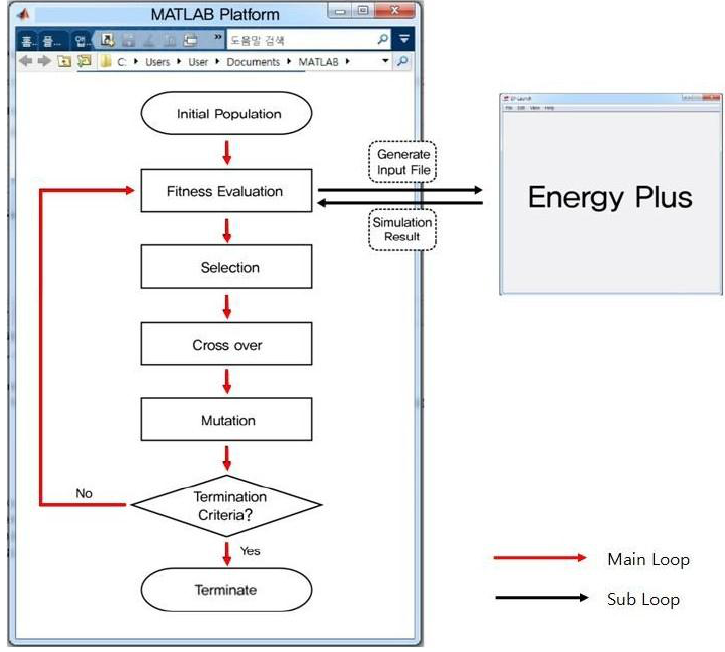
Figure 5. GA Algorithm Flow of MATLAB Related with Energy Plus.